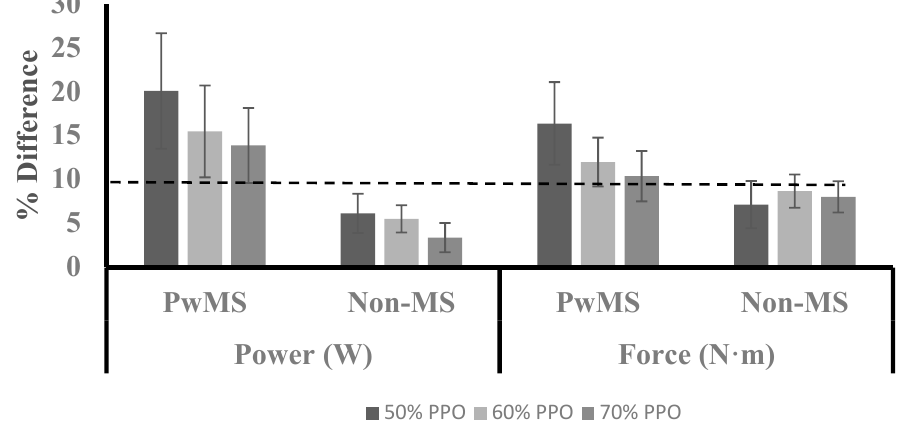
Figure 1. Average lower limb asymmetry in power and force. Data are presented as mean ± standard error. Dotted line indicates 10% threshold for asymmetry.